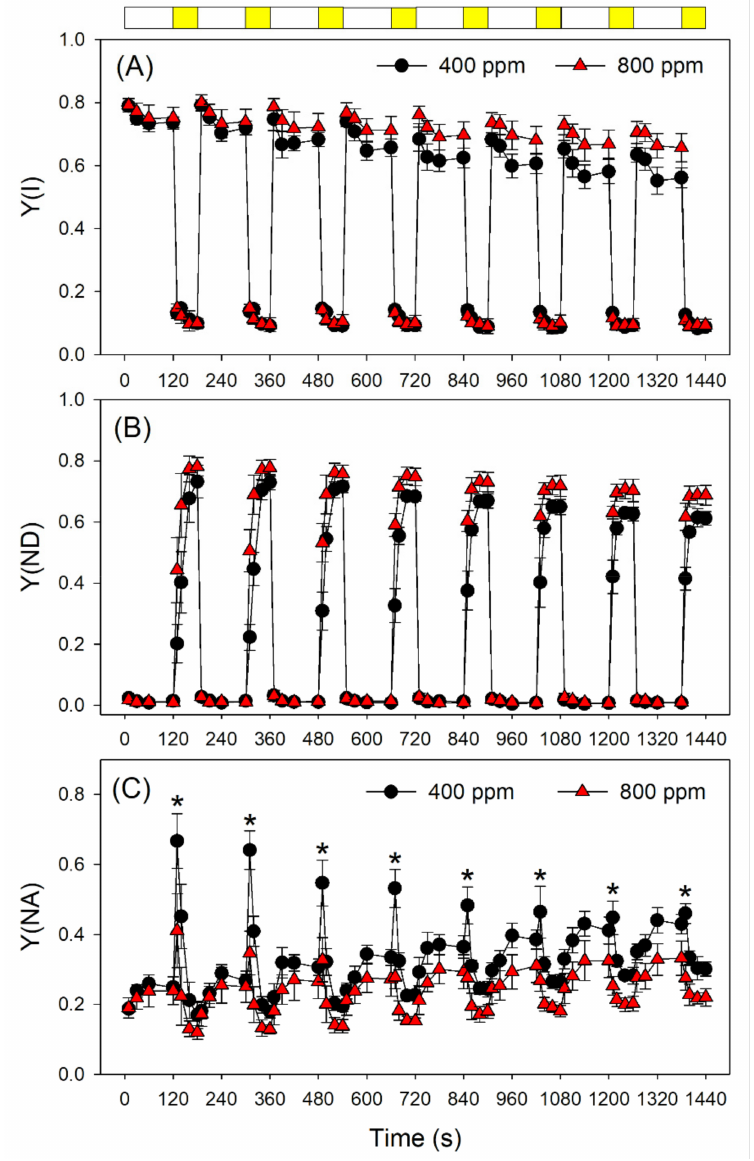
Figure 3. Changes in PSI parameters during fluctuating light alternating between 59 and 1809 µ mol photons m − 2 s − 1 in Arabidopsis leaves, measured in 400 and 800 ppm CO 2 . ( A ) Y(I), the quantum yield of PSI photochemistry; ( B ) Y(ND), the quantum yield of PSI non-photochemical energy dissipation due to the donor side limitation; ( C ) Y(NA), the quantum yield of PSI non-photochemical energy dissipation due to the acceptor side limitation. Data are shown as means ± SD ( n = 5). White bars indicate low light (59 µ mol photons m − 2 s − 1 ); yellow bars indicate high light (1809 µ mol photons m − 2 s − 1 ). Asterisk indicates a significant different between 400 and 800